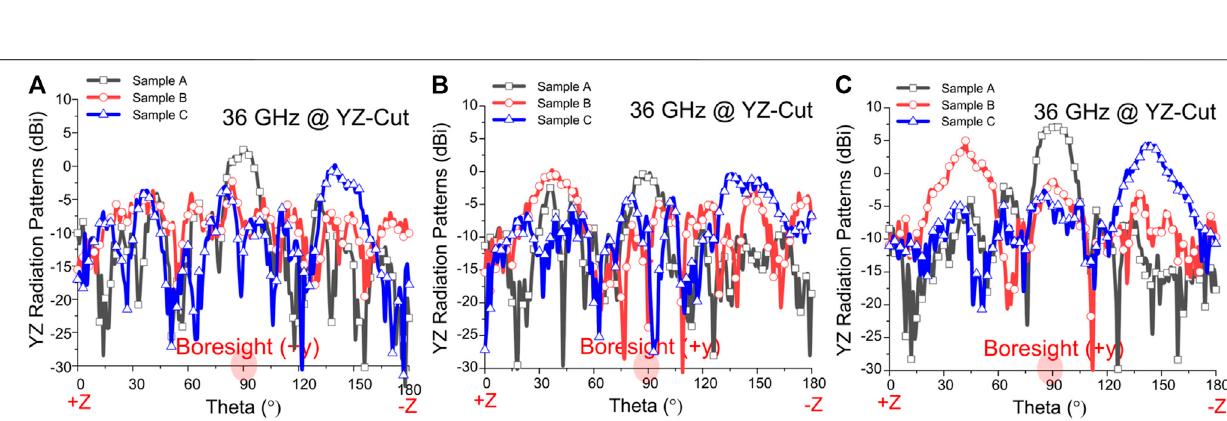
FIGURE8| Measuredradiationpatterns( E theta -polarization and30 GHz)ofthefabricatedarraysforthebeamsteeringtestinthehandsetmockup. (A) CPWTL. (B) GCPW TL without via fences. (C) GCPW TL with via fences.